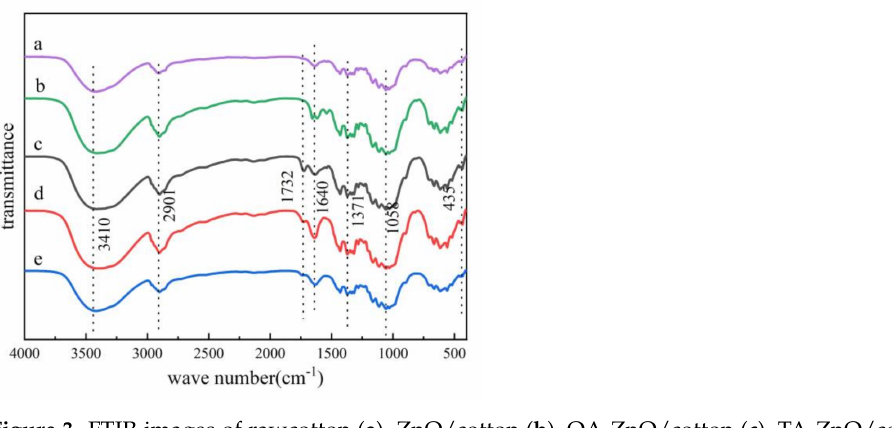
Figure 3. FTIR images of rawcotton ( a ), ZnO/cotton ( b ), OA-ZnO/cotton ( c ), TA-ZnO/cotton ( d ) and SA-ZnO/cotton ( e ).